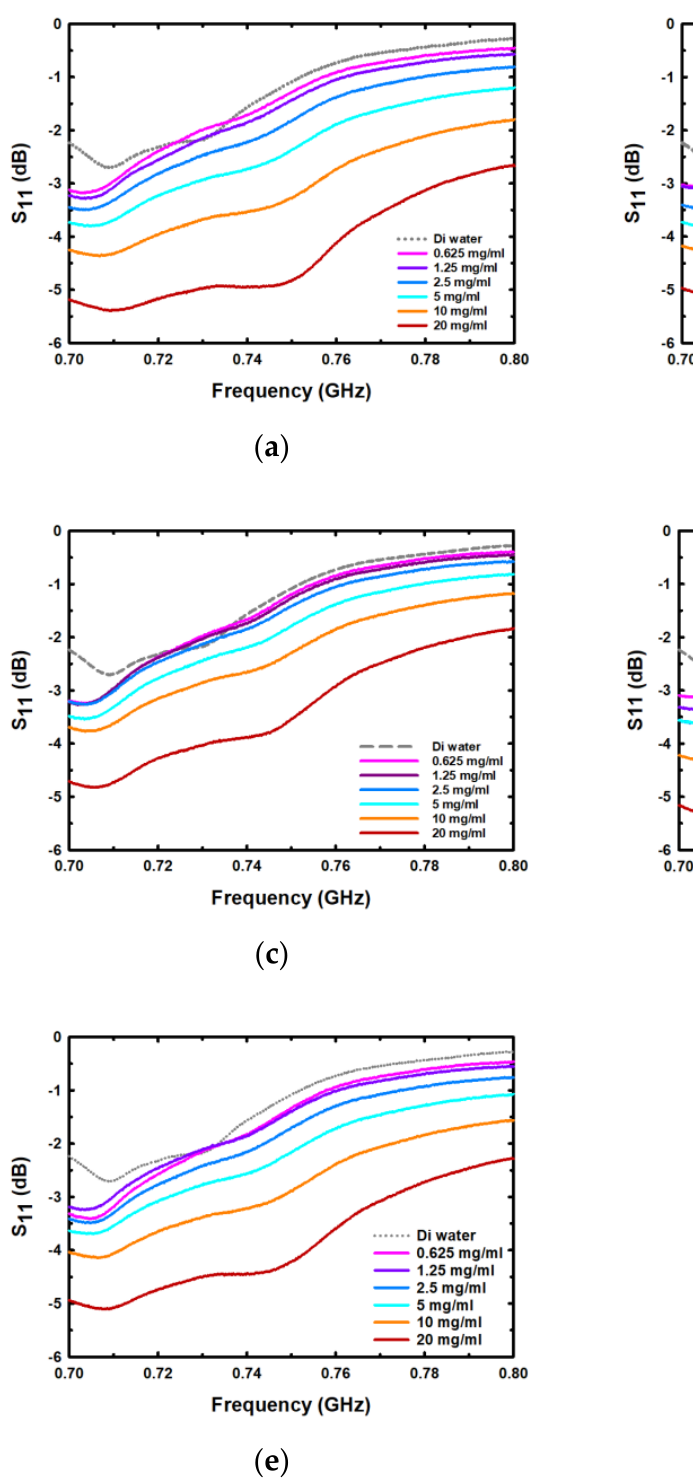
Figure 6. The reflection coefficient spectra in the frequency range from 0.7 GHz to 0.8 GHz for the third resonance peak for different concentrations of ( a ) sodium chloride (NaCl), ( b ) potassium chloride (KCl), ( c ) magnesium chloride (MgCl 2 ), ( d ) calcium chloride (CaCl 2 ), and ( e ) sodium carbonate (Na 2 CO 3 ). Table 2. The equations and parameters of this relationship for each salt in the frequency range of the first resonance peak.